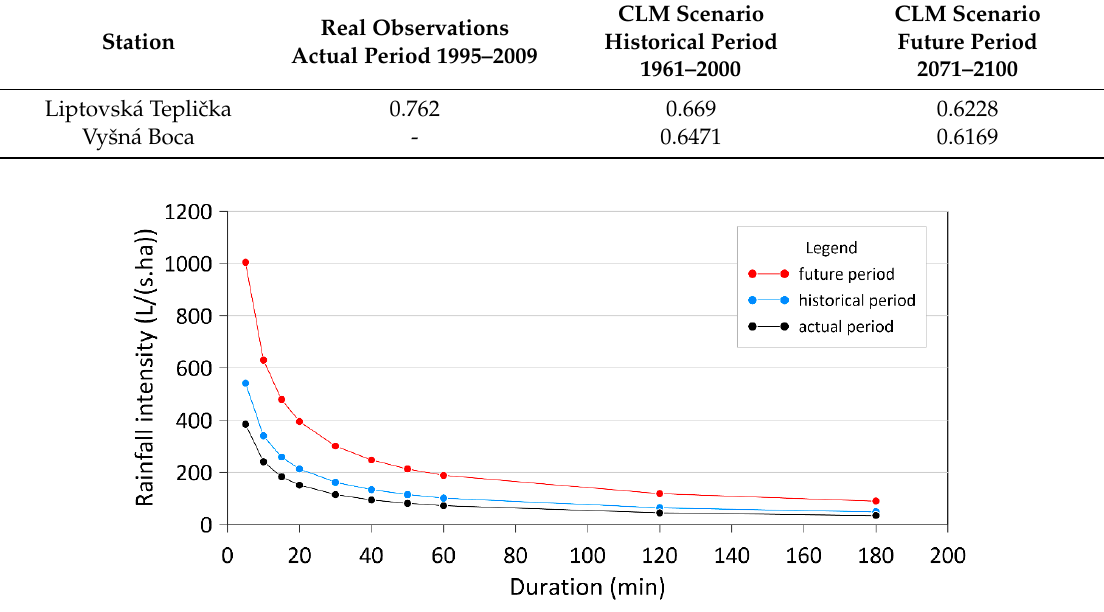
Table 7. Scaling exponents for the stations analyzed for the historical and future periods.